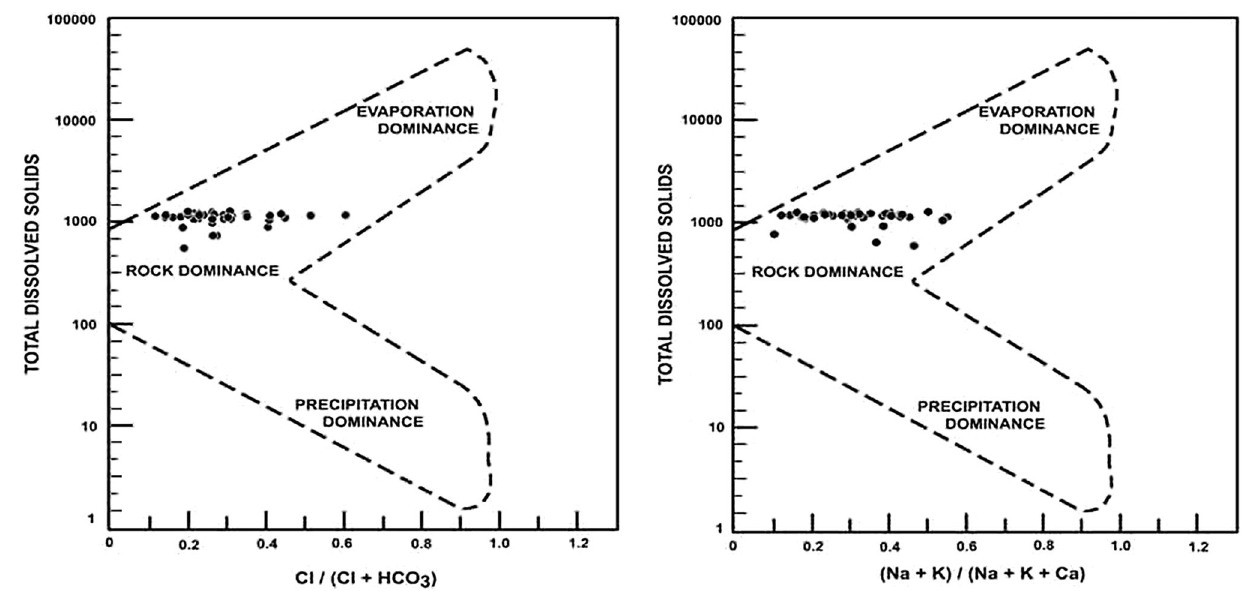
Fig. 9 Mechanism controlling the quality of